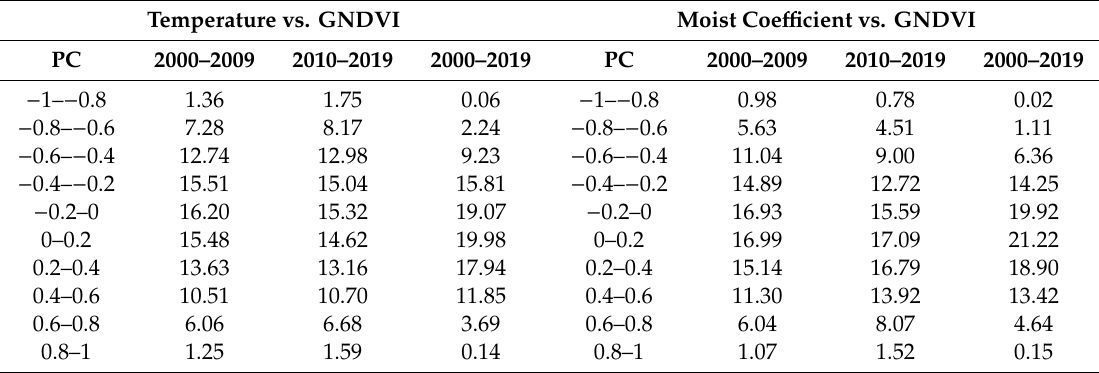
Table 4. The areal proportion of di ff erent partial correlation levels in di ff erent study periods on the QTP